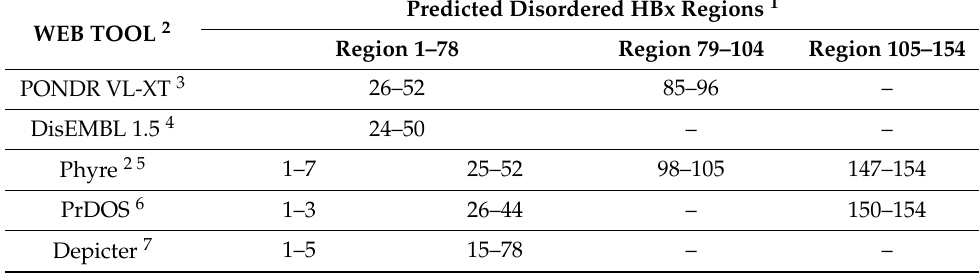
Table 1. Analyses of HBx disordered regions. WEB TOOL